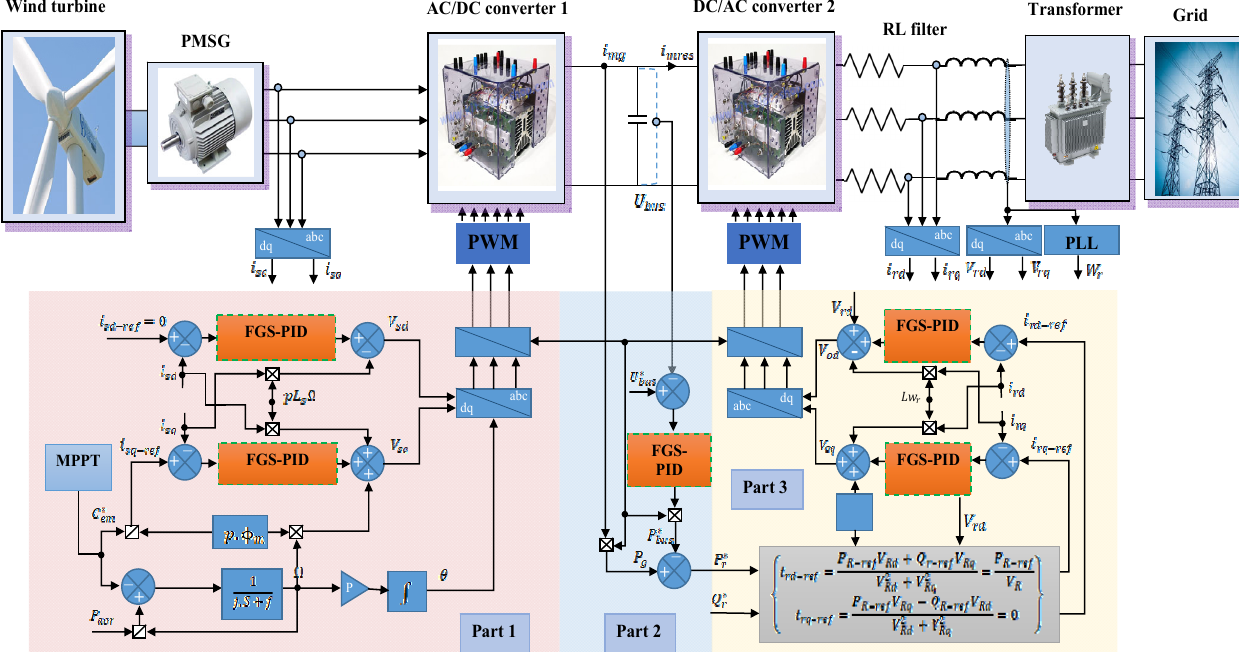
Figure 7. Schematic of WECS VCS-FGS-PID controller.